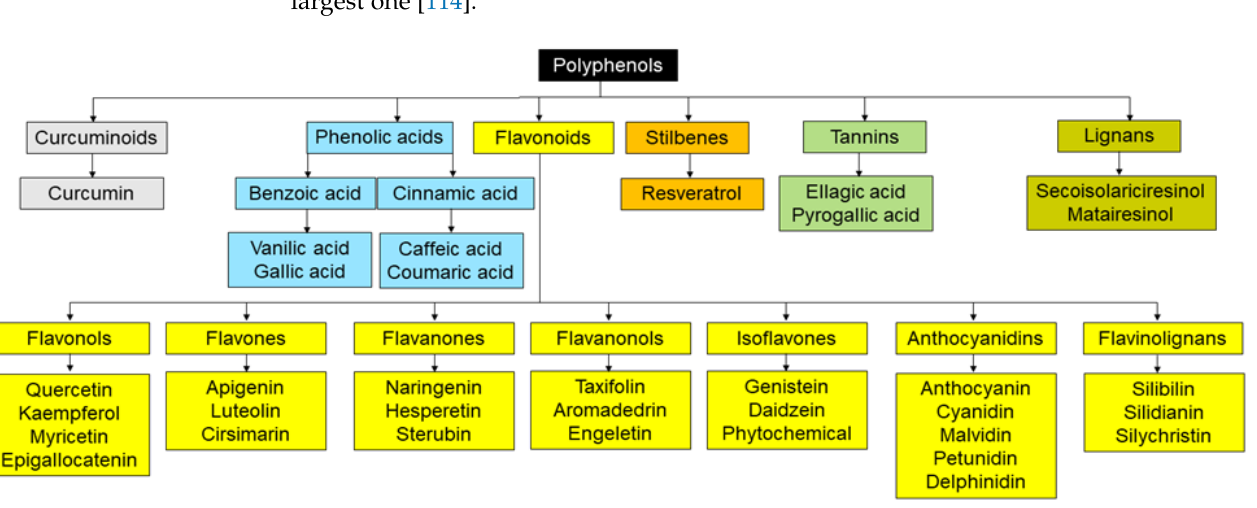
Figure 2. Classification of Polyphenols.